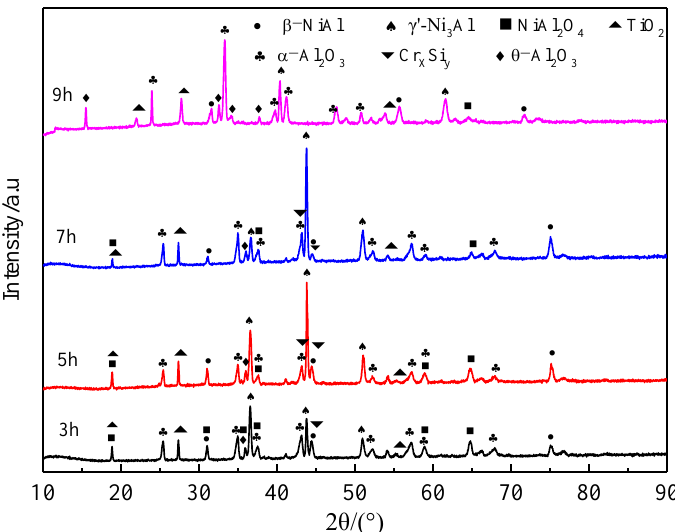
Figure 16. XRD patterns of Al-Si coatings with different pre-oxidation times at 1000 °C for 300 h.